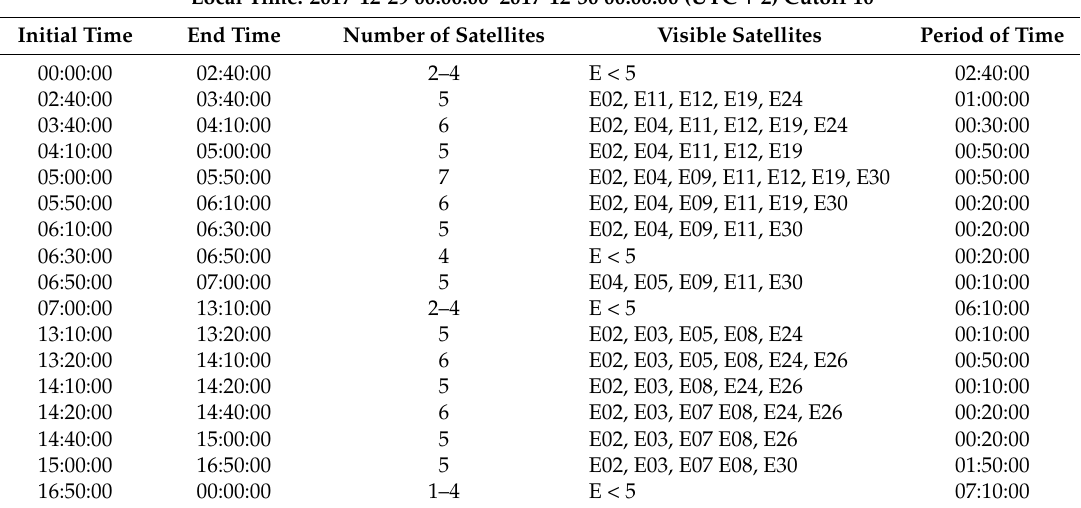
Table 2. Galileo satellites availability for the Day of Year: 363, 2017.